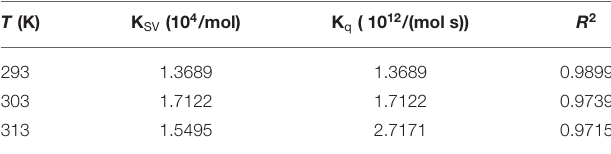
TABLE 1 | Lutein induces the Stern–Volmer quenching constant (K SV ) and bimolecular quenching rate (K q ) of GSPI at different temperatures (293, 303, and 313